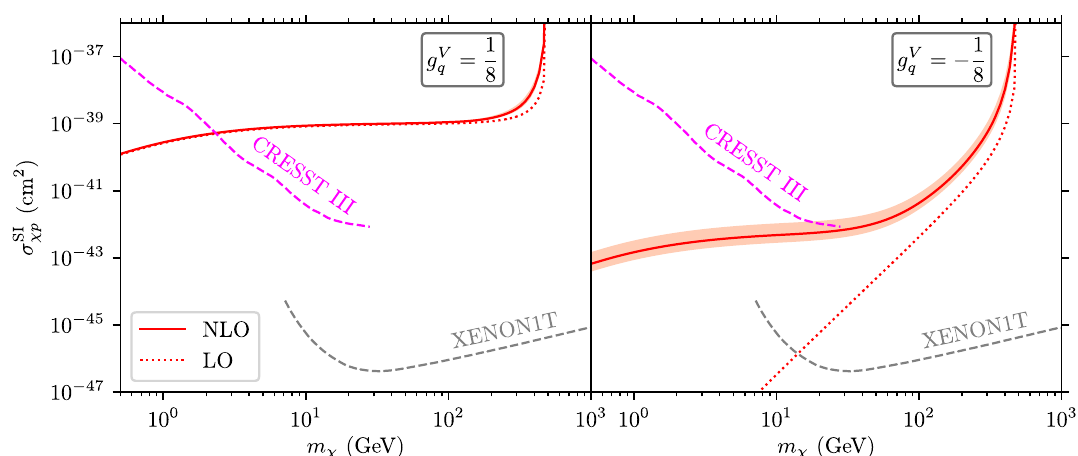
Fig. 9 Theoretical predictions at LO (dotted blue) and NLO (solid hatched blue area) for σ SI p together with bounds from CRESST and XENON for an s + t -channel model with g V q = 1 / 8 (left panel) and g V q = − 1 / 8 (right